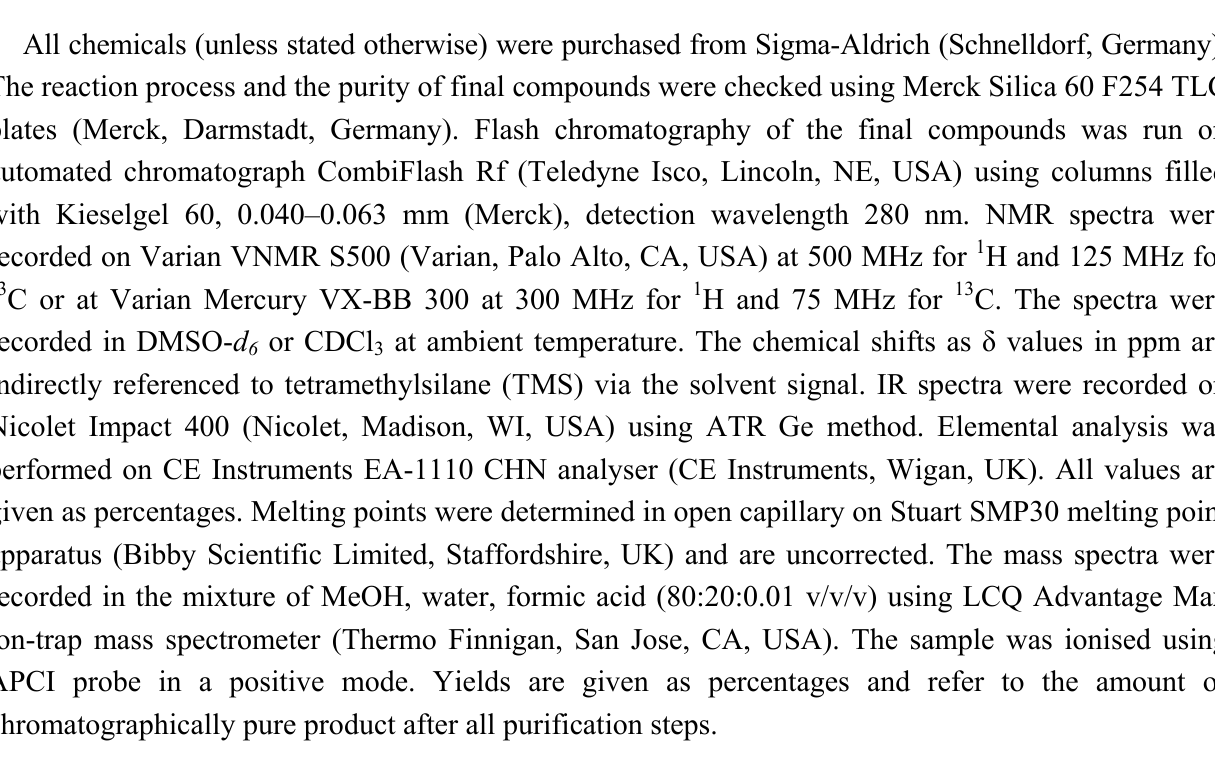
: Mean ± SEM (µM) (n = 3) where applicable. SI = IC 50